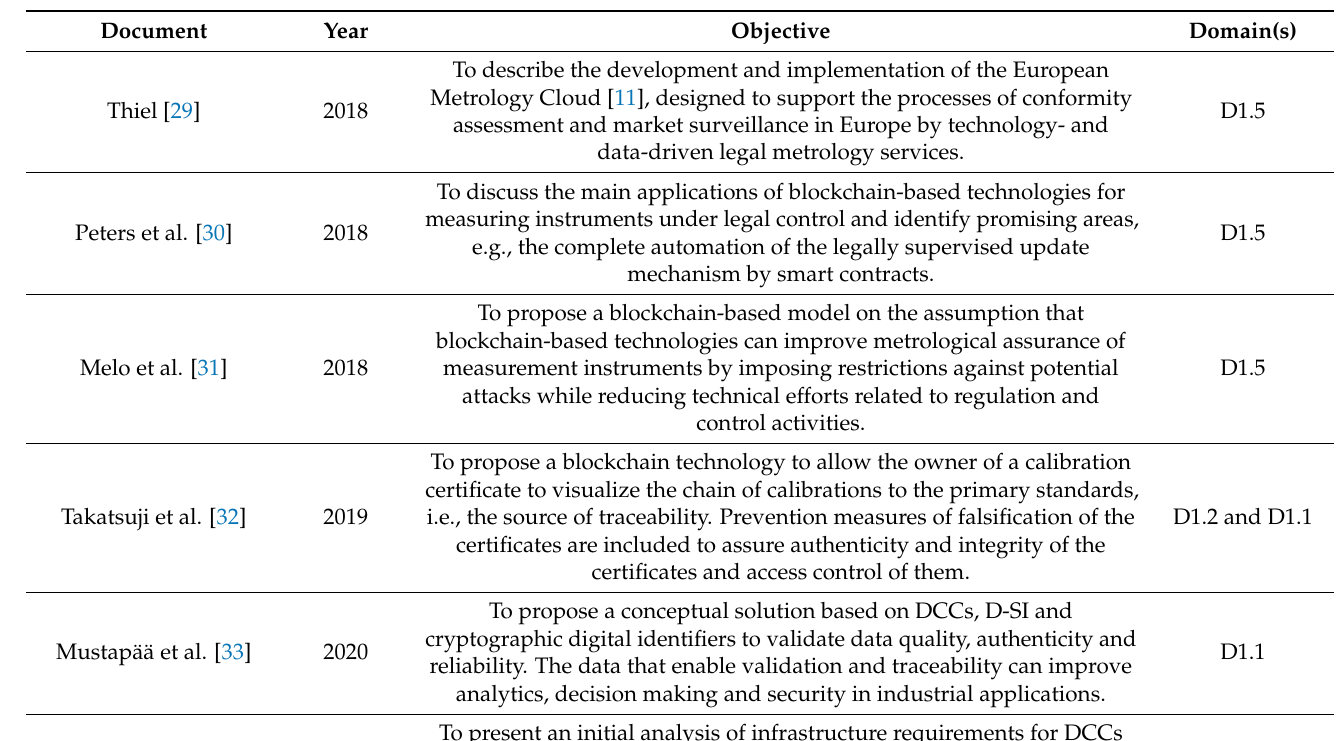
Table 4. Documents reviewed in the “Digital transformation of metrological services”